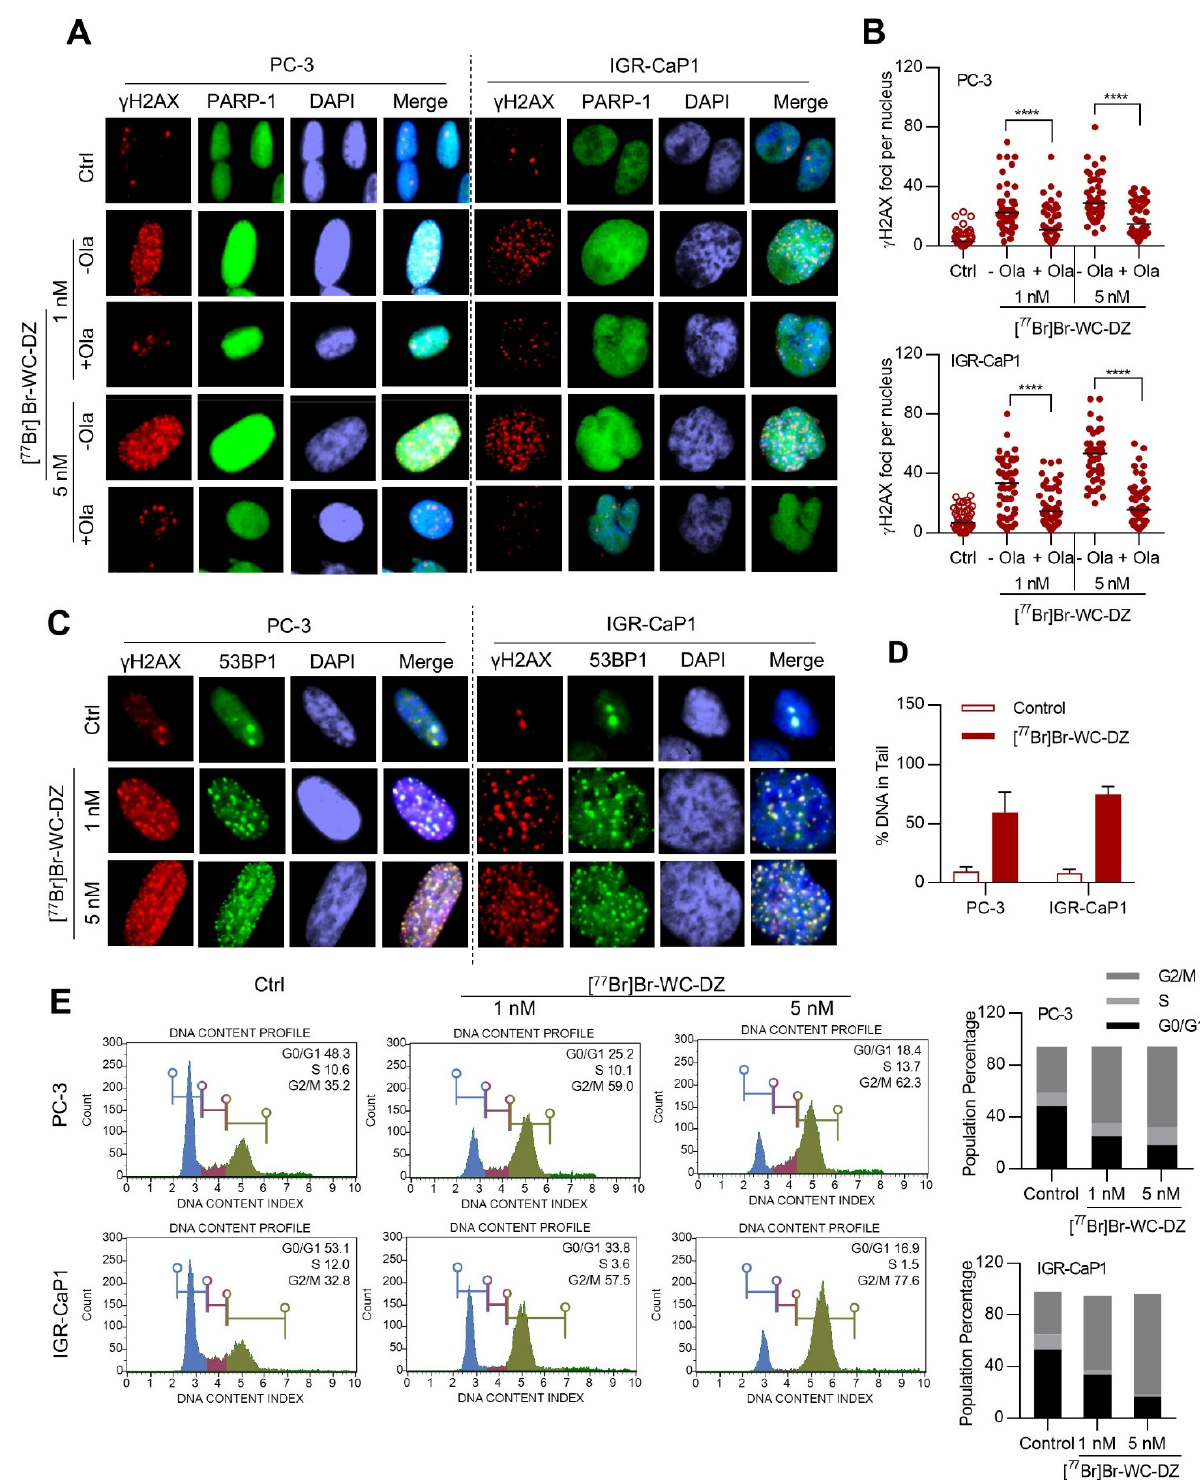
Figure 3. The [ 77 Br]Br-WC-DZ-induced DNA damage arrest of the cells at the G2/M checkpoint. ( A , C ), immunofluorescence of γ H2AX, PARP-1, and 53BP1 in PC-3 and IGR-CaP1 cells after 24-h treatment with [ 77 Br]Br-WC-DZ (1 nM/5 nM) in the presence and absence of olaparib (20 µM). Representative immunofluorescence images are shown. The original images were captured at 100× (PC-3) and 63× (IGR-CaP1) magnification with oil immersion. ( B ), γ H2Ax foci counts per nucleus in the cells treated with [ 77 Br]Br-WC-DZ. γ H2Ax foci were counted on at least 50 cells per treatment,